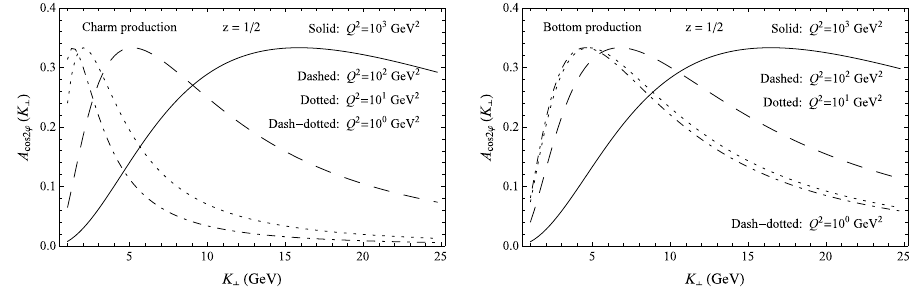
Figure 2. Azimuthal cos2 ϕ asymmetry A cos2 ϕ ( K ⊥ ) ≡ A cos2 ϕ ( z = 1 / 2 , K ⊥ ) in charm (left panel) and bottom (right panel) production as a function of K ⊥ =